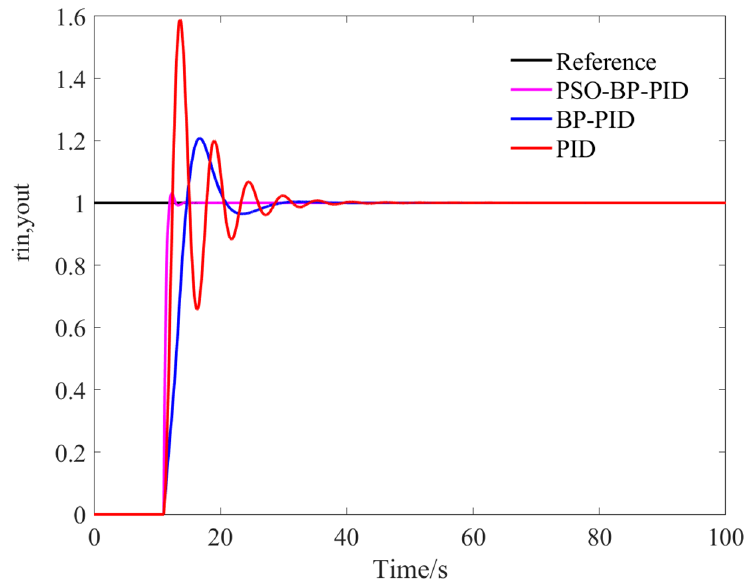
Figure 9. Comparison of the control effect of three controllers under unit step response. Table 1. Dynamic performance of the three